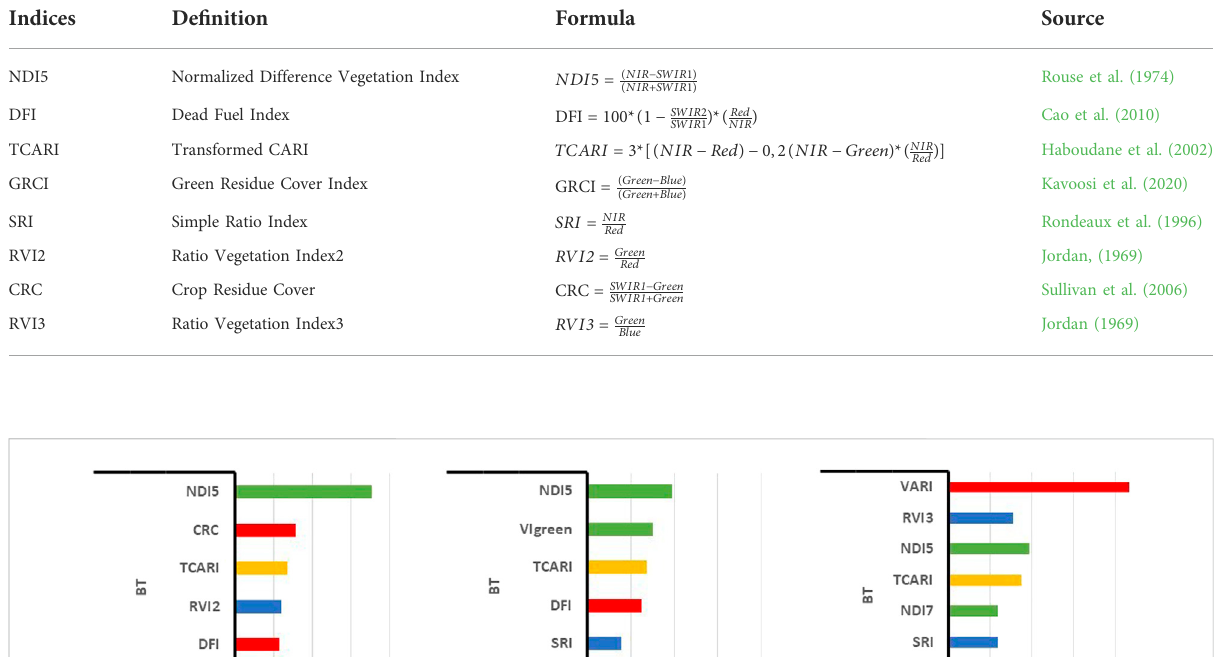
TABLE 2 List of the vegetation indices used in the development of the models.